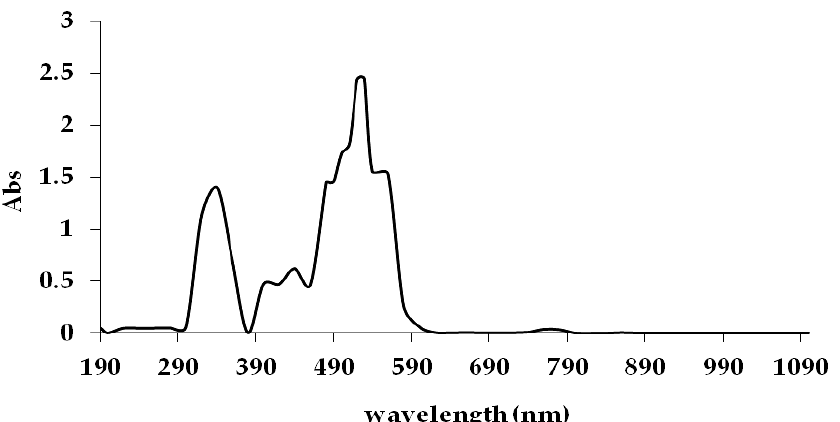
Figure 1. Scanning absorption spectrum of Reactive Red 120 at different wavelength (nm). Maximum absorption was obtained at 525 nm.